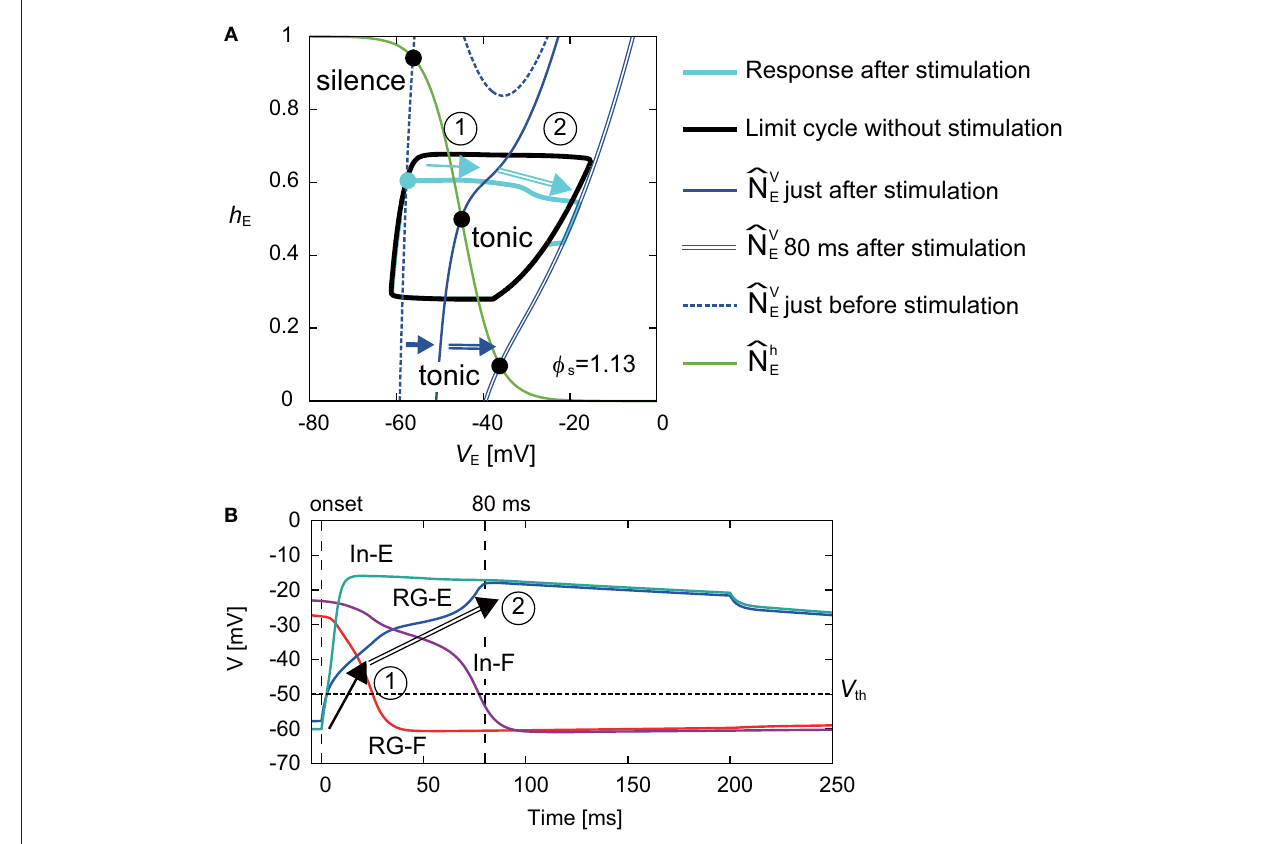
FIGURE 6 | (A) Response of RG-E neuron on the V E - h E plane by stimulating the extensor side at φ s = 1.13rad. The black line shows the limit cycle without stimulation. Stimulation was applied at filled cyan circle. The blue dashed and solid lines show ˆ N V E just before and after the stimulation, respectively. While ˆ N V E moved to the right just after the stimulation and the intersection with ˆ N h E (green line) became tonic mode, the disturbed trajectory (cyan line) moved to the right without entering the limit cycle ( ‹ ). ˆ N V E gradually further moved to the right (blue double line shows ˆ N V E at 80ms after the stimulation) and the trajectory was finally cut short to the limit cycle ( › ). (B) Time profiles of four neurons from the onset of the stimulation to the end of the shortcut. The vertical lines show the onset and 80ms after the stimulation. The horizontal line shows V th . After the stimulation, the membrane potentials of the RG-E and In-E neurons rapidly changed and crossed over V th ( ‹ ). After that, while the membrane potentials of the RG-F and In-F neurons decreased due to the inhibitory signal from the In-E neuron and crossed over V th , the membrane potential of the RG-E neuron gradually increased. As a result, the decrease of the inhibitory signal from the flexor side increased the activity of the RG-E, which induced the shortcut ( ›